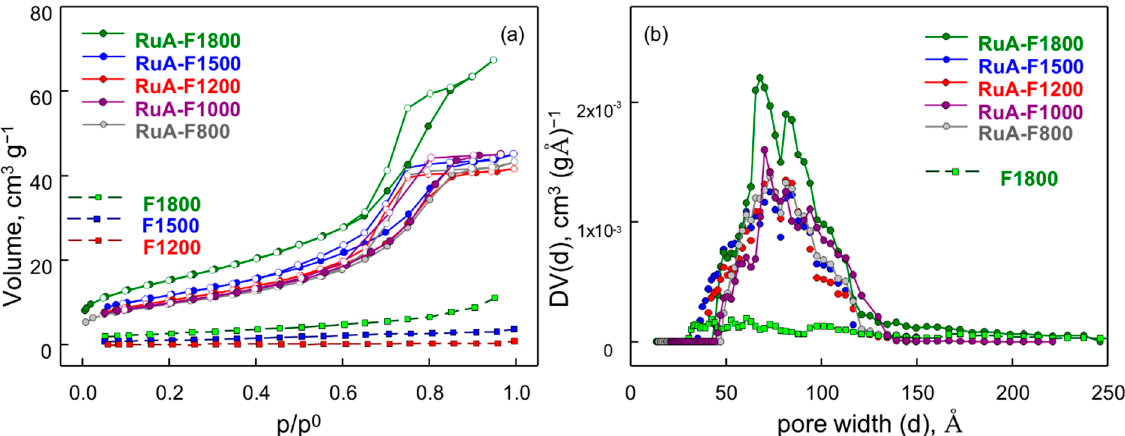
Figure 5. N 2 adsorption (full symbols)/desorption (empty symbols) isotherms ( a ) and correspond- ing pore size distribution analysis ( b ) for selected RuA-Fxxxx reduced catalysts (circles) and their corresponding bare SiC foam substrates (squares).